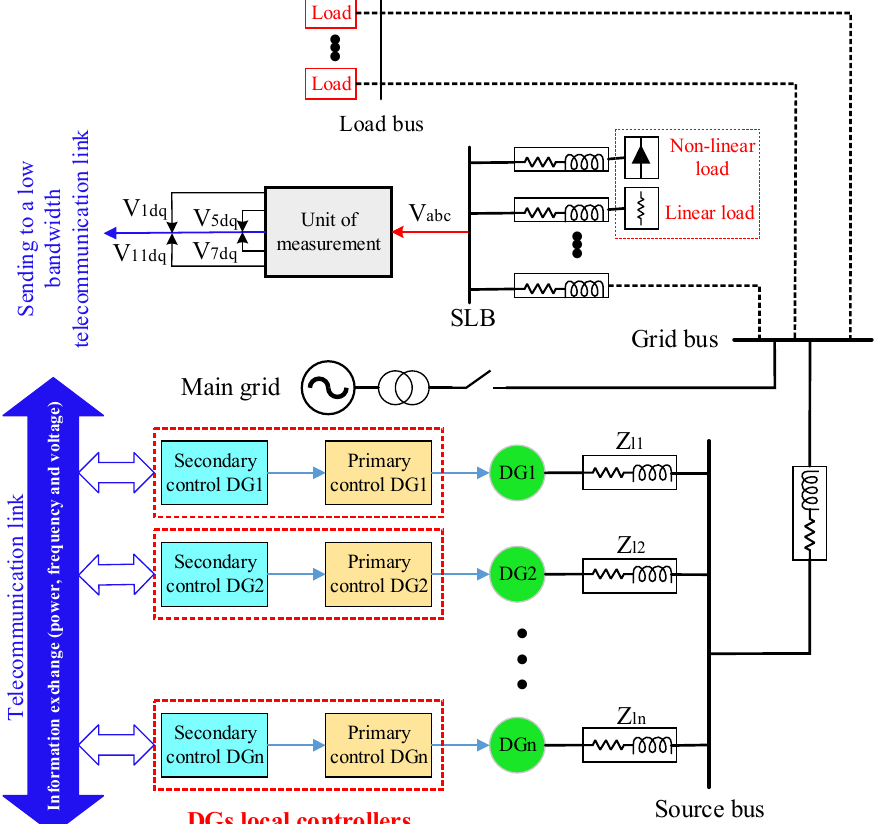
Figure 1. The general structure of microgrid control.